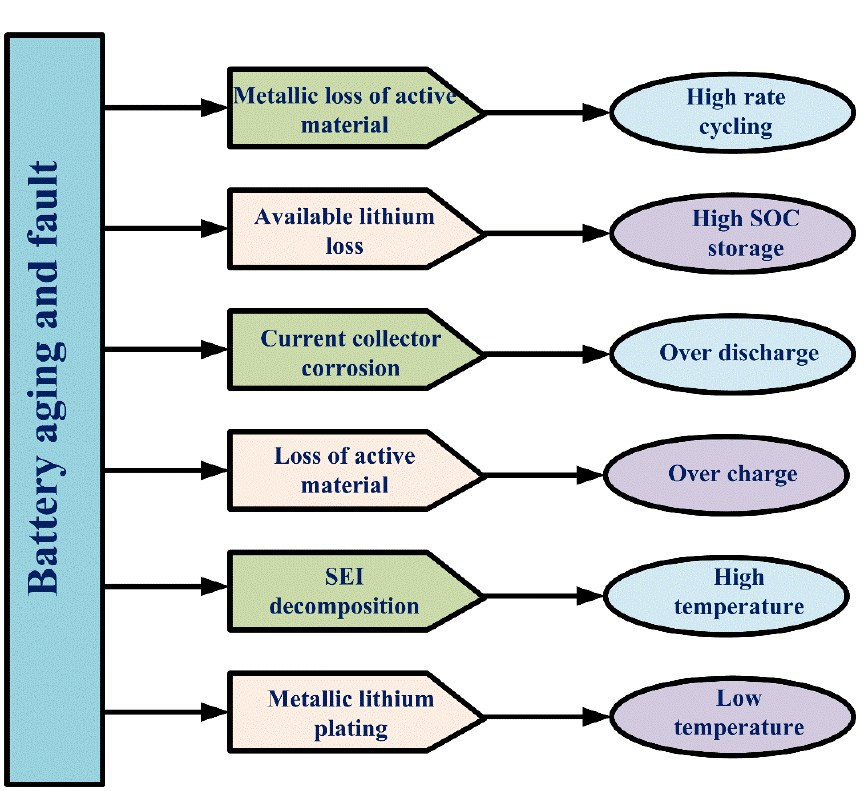
Figure 17. Explanations for the aging of a battery at the anode [145].